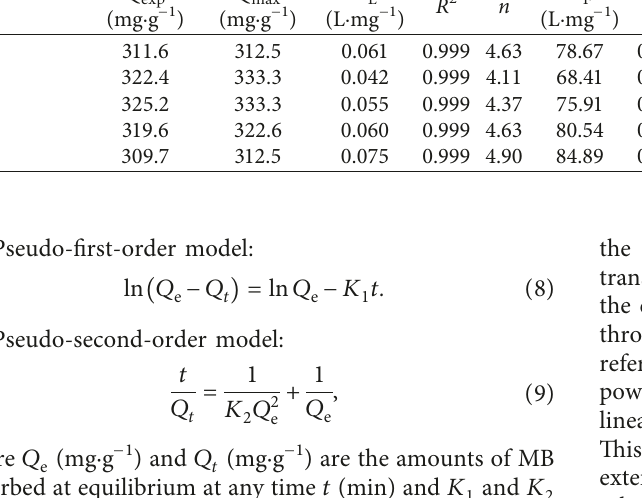
Table 2: Adsorption isotherm fittings for the MB adsorption onto wasted tea powder.